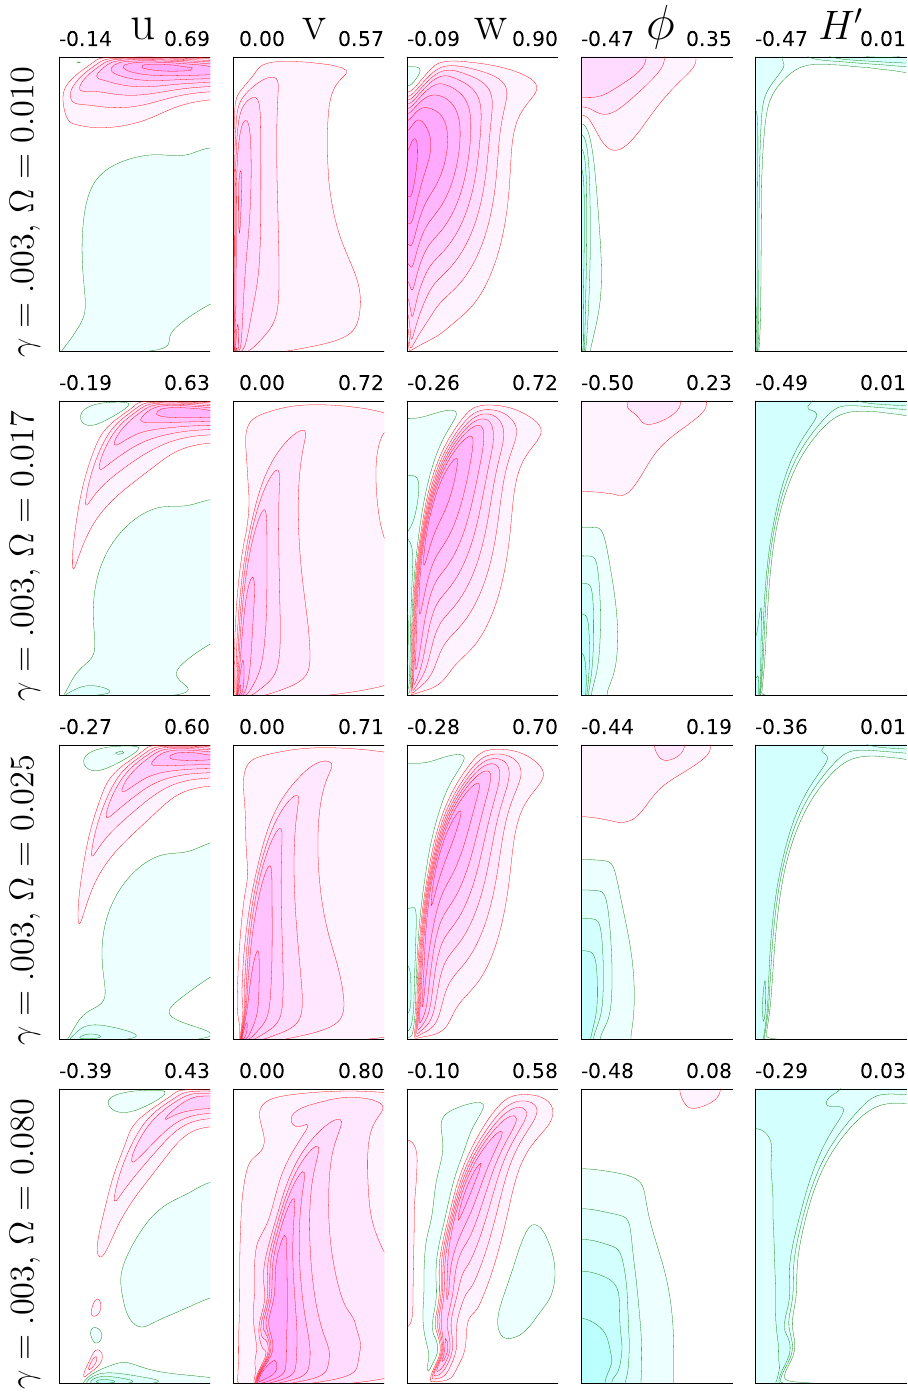
Figure 5. Simulations with γ = 0.003 at t =